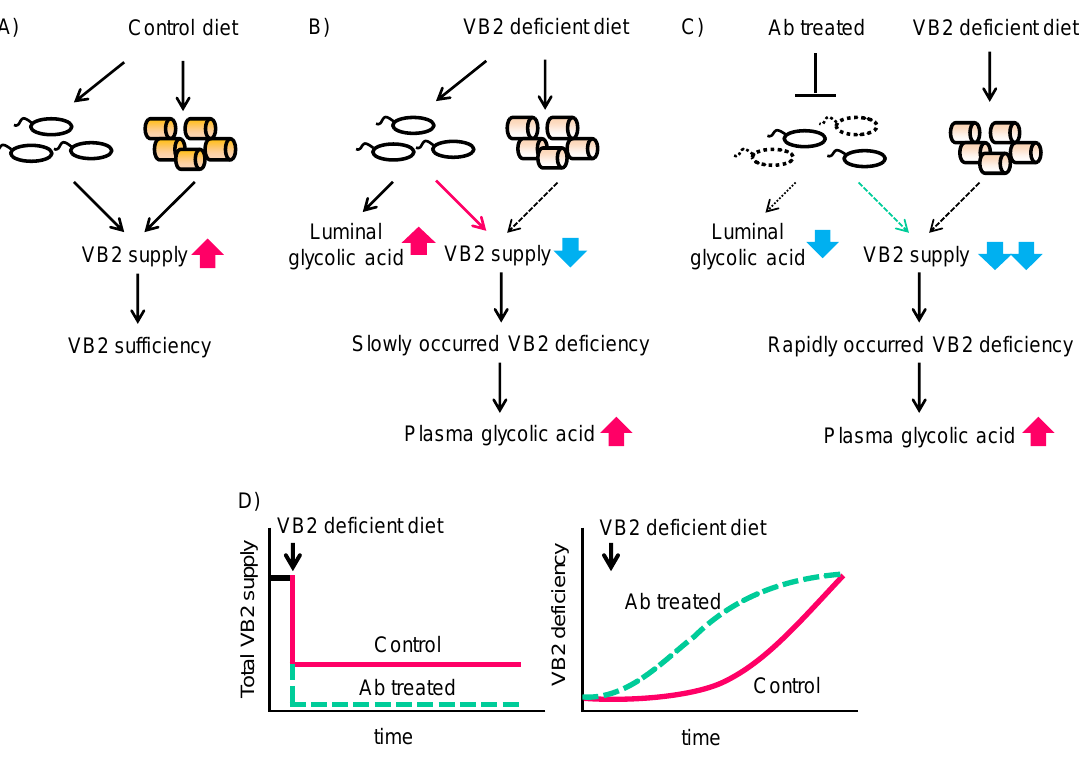
Figure 6. Interaction of dietary VB2, the gut microbiota, and glycolate accumulation in gut microbiota and the mouse host. ( A ) Control diet feeding with normal gut microbiota sustains a sufficient VB2 supply from both sources and preserves VB2 sufficiency. ( B ) VB2- diet feeding with normal gut microbiota sustains a VB2 supply from the gut microbiota only in the short term and before VB2 deficiency gradually develops. ( C ) Feeding of a VB2- diet in the presence of disrupted gut microbiota due to antibiotic treatment does not sustain adequate VB2 supplies and rapidly induces VB2 deficiency. ( D ) Time course of total VB2 supply ( left ) and VB2 deficiency ( right ) in mice fed the VB2- diet with or without antibiotic treatment.